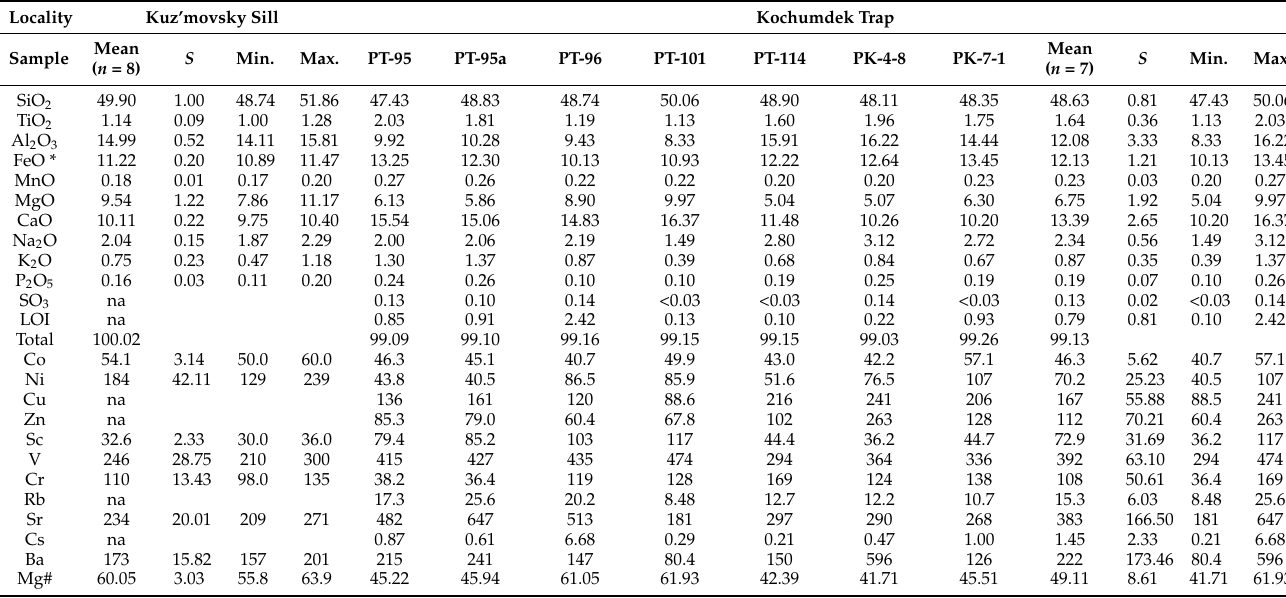
Table 1. Major (in wt%) and trace element compositions (in ppm) of gabbro from the Kochumdek trap and dolerites from the Kuz’movsky